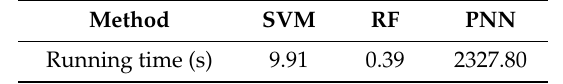
Table 4. Comparison of the running time for the SVM, RF, and the